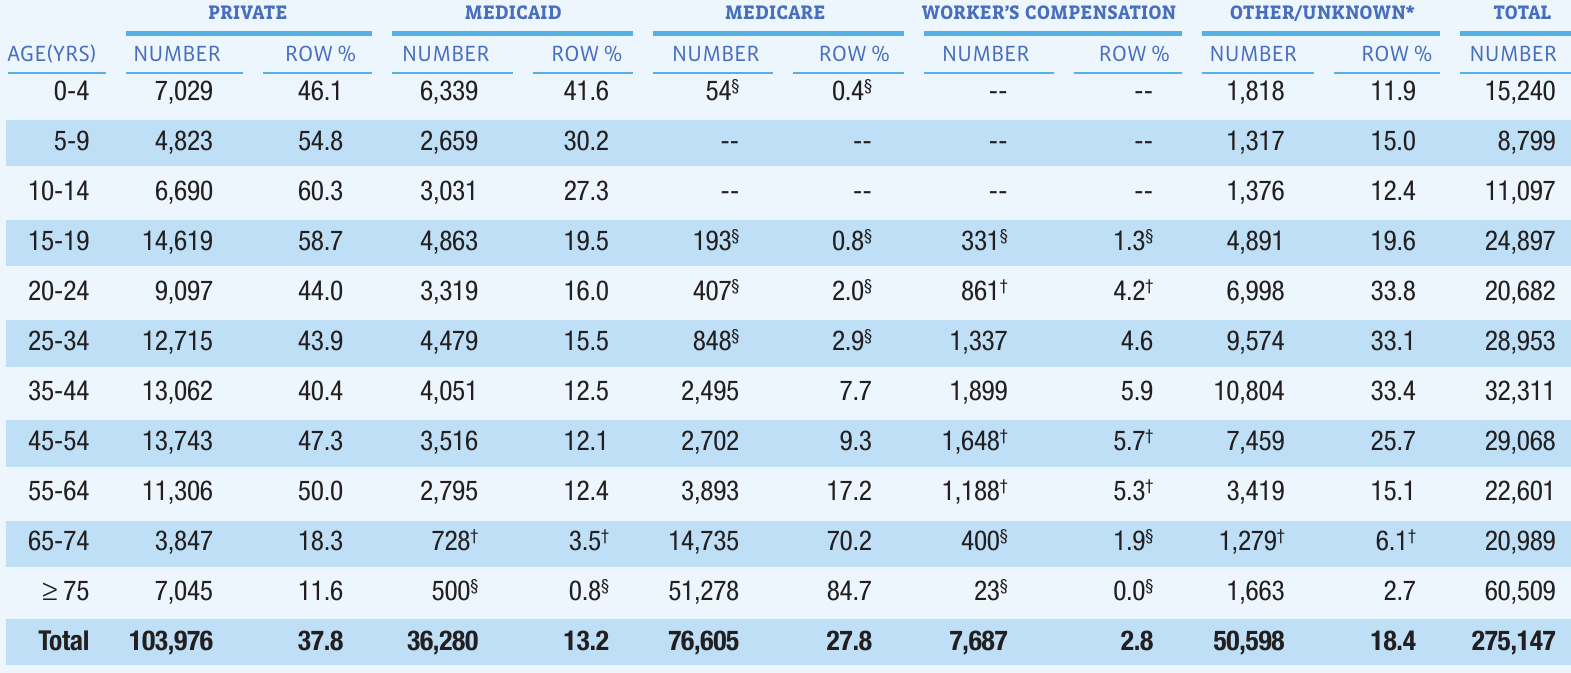
TABLE 13: Estimated Average Annual Numbers and Percentages of Traumatic Brain Injury-Related Hospitalizations, by Age Group and Expected Source of Payment, United States,